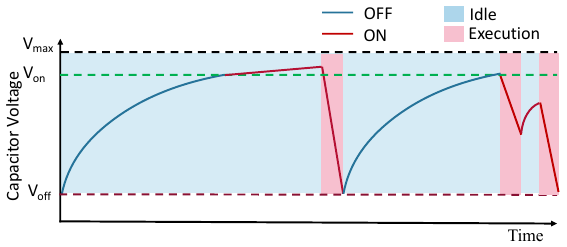
Figure 1. Intermittent behaviour of capacitor enabled device harvesting